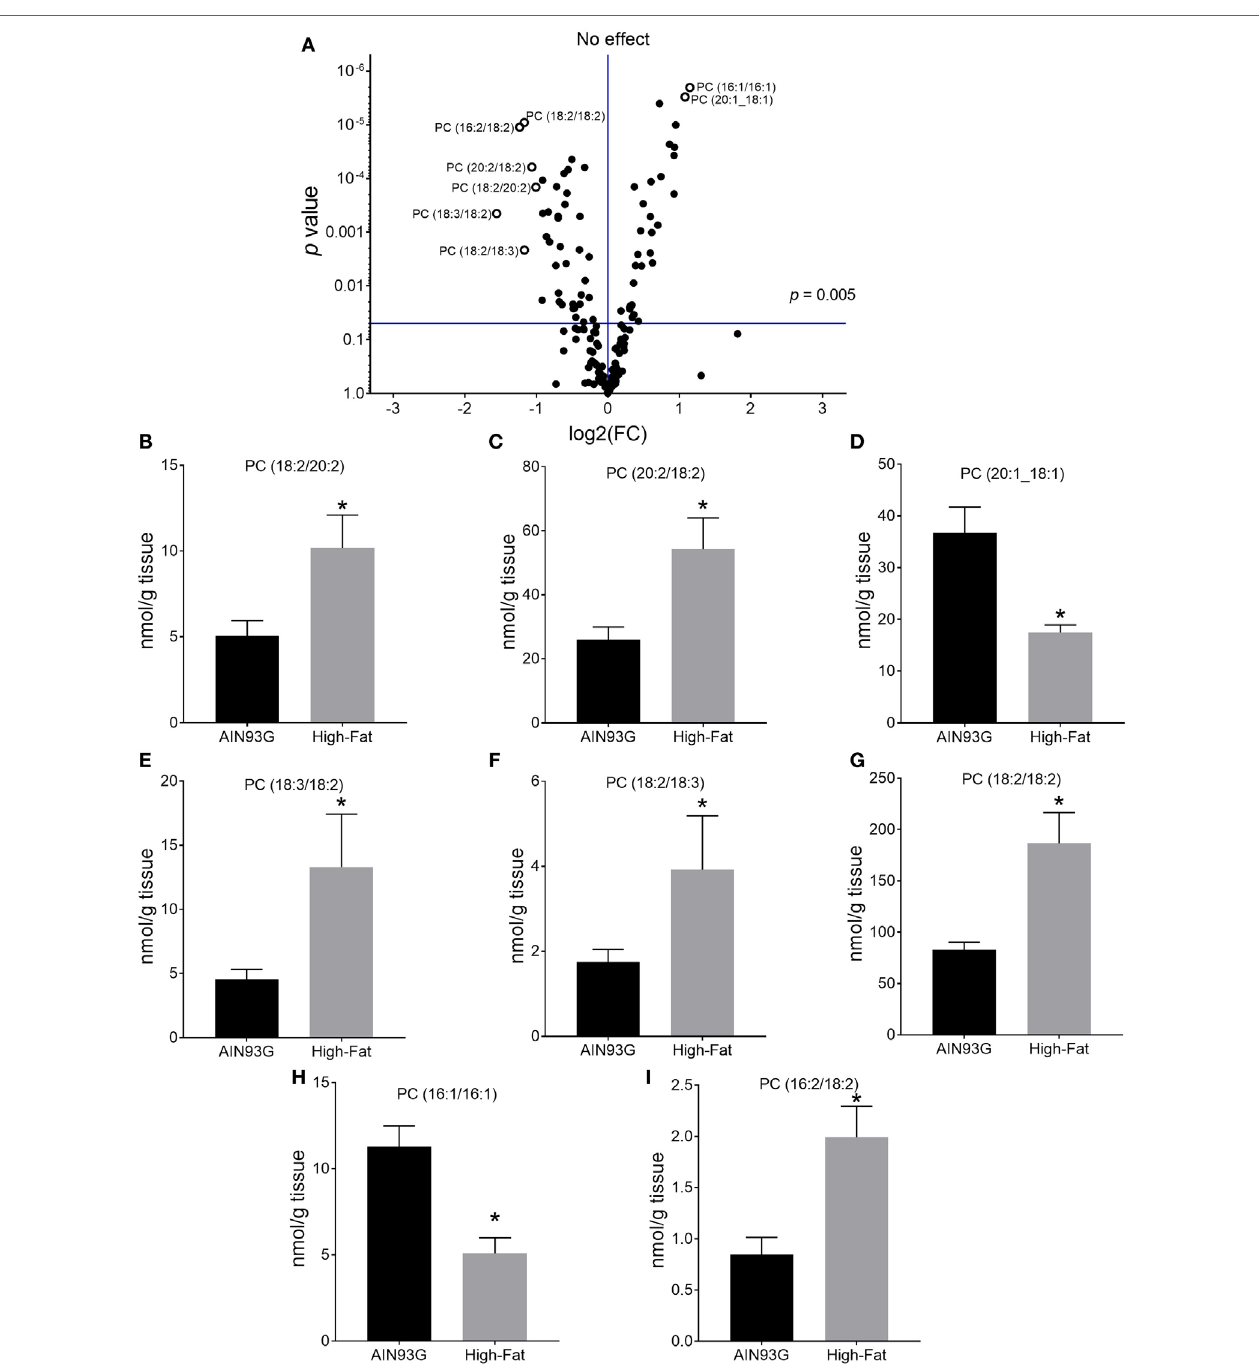
FigUre 1 | Volcano plot (a) and concentrations of selected phosphatidylcholines [PCs; (b–i) ] in the primary tumor of Lewis lung carcinoma with a twofold or greater difference between the AIN93G diet and the high-fat diet. Values are mean ± SD ( n = 6 per group). * p ≤ 0.05 for each